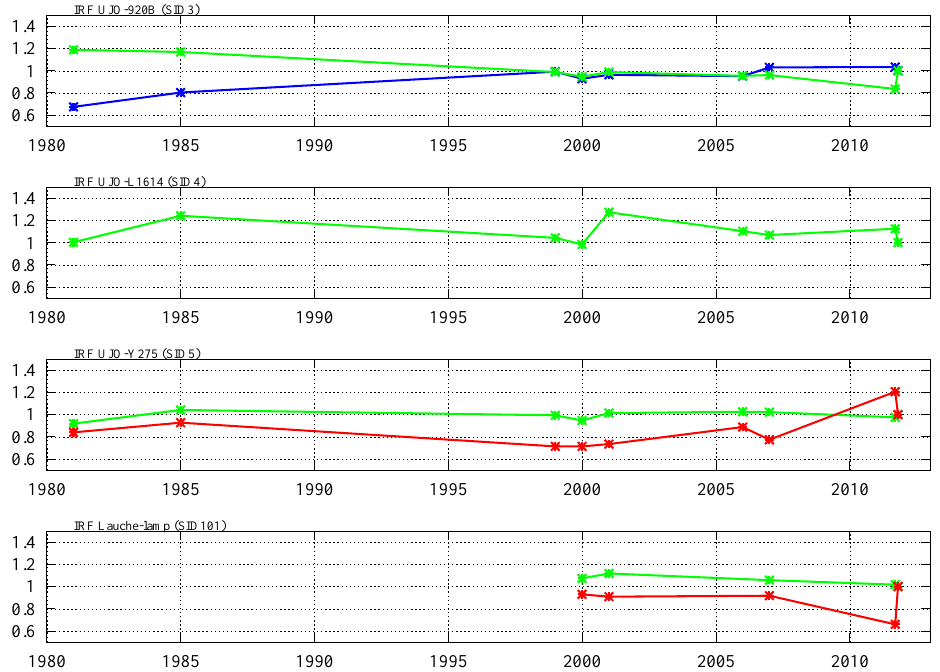
Fig. 4. Ratios of 2011b intercalibration in Sodankyl¨a to earlier intercalibrations for IRF UJO 920B (SID3, top panel), IRF UJO L1614 (SID 4), IRF UJO Y275 (SID5) and IRF Lauche lamp (SID101) (bottom panel): (blue) 4280 ˚A, (green) 5573 ˚A and (red) 6299 ˚A. Note that none of these sources were intercalibrated 1987–1995.